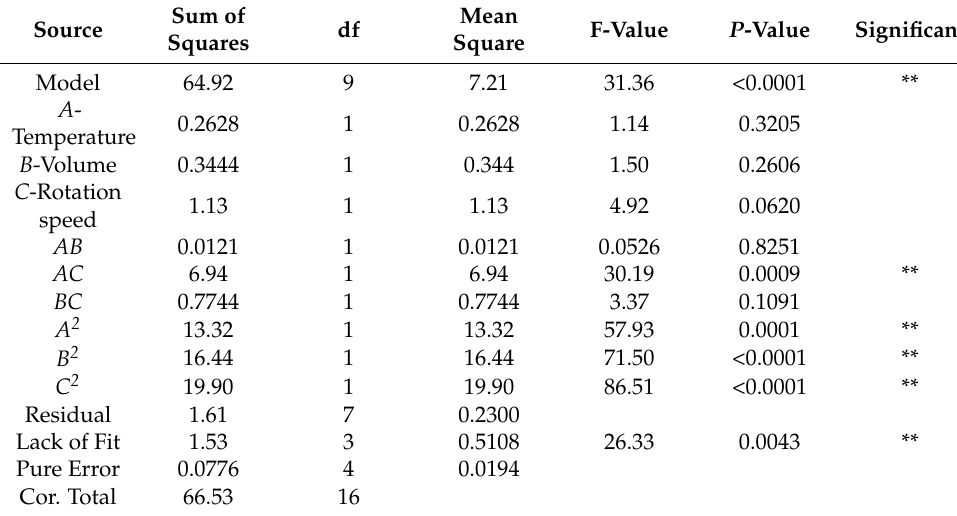
Table 7. Analysis of variance of response surface quadratic